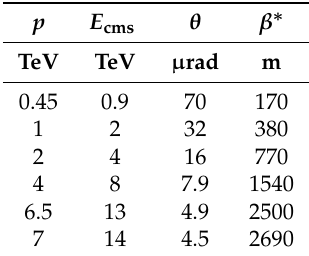
Table 1. Energy scaling of the scattering angle θ and β ∗ at fixed | t | = 10 − 3 GeV 2 as relevant for measurements of the ρ -parameter in the CI-interference